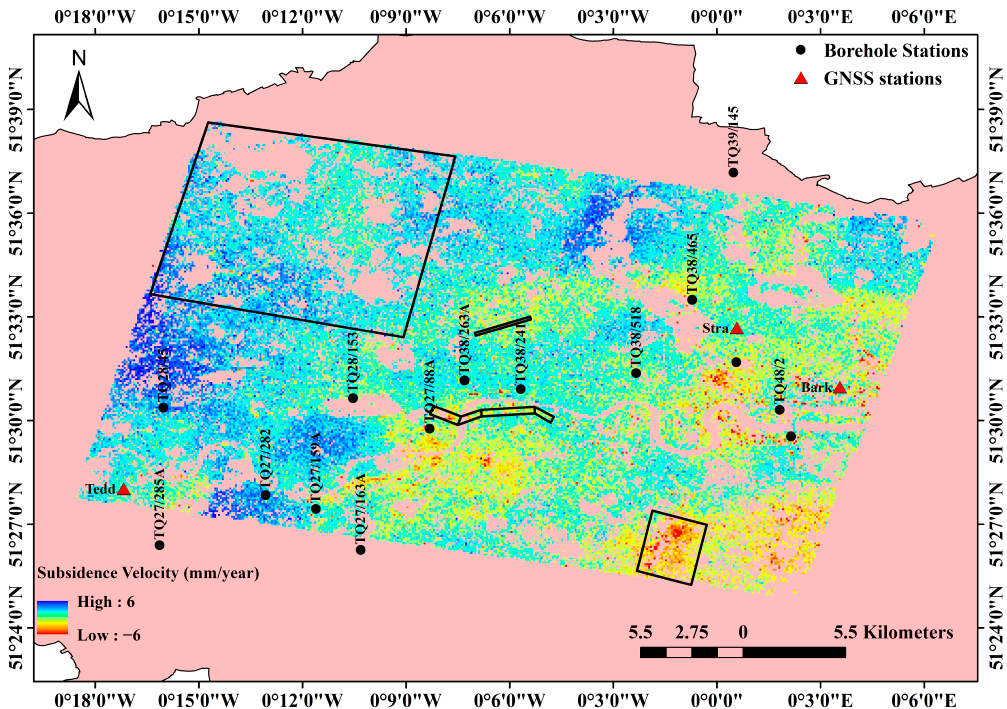
Figure 3. Line of Sight (LOS) average land deformation map for central London (blue areas depict uplift, while the red areas depict subsidence) with the location of observed boreholes (black dots), observed GNSS stations (red triangle) and four land movement sites (black boxes, detailed in Figure